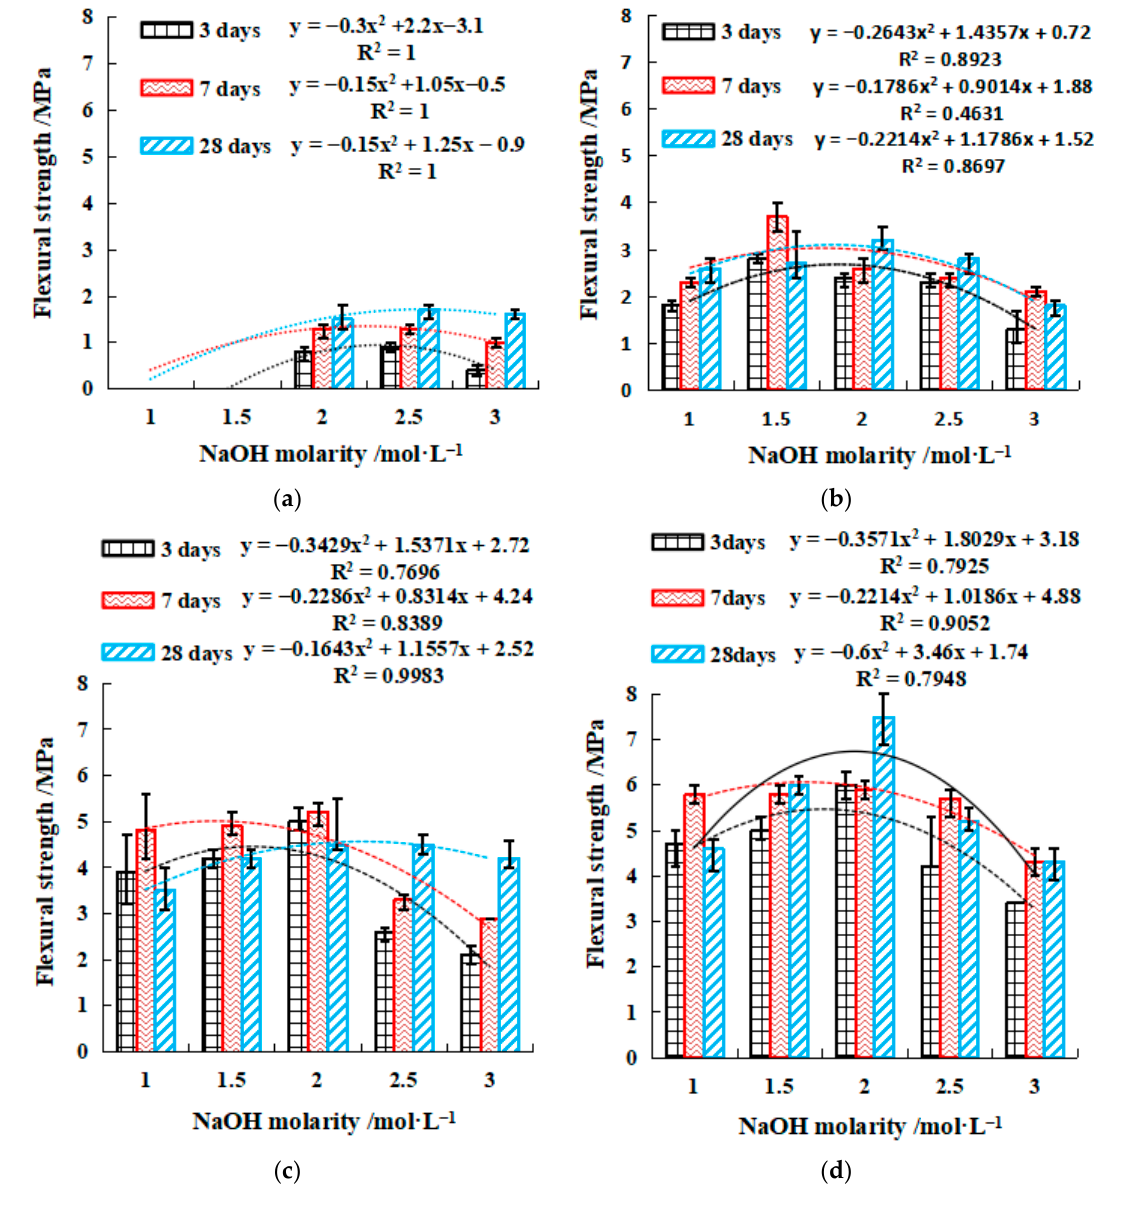
Figure 5. Flexural strength of single activator. ( a ) 10% GGBFS, ( b ) 20% GGBFS, ( c ) 30% GGBFS, ( d ) 40% GGBFS. y = ax 2 + bx + c, where y is the compressive or flexural strength, MPa. x is the NaOH molarity,1 ≤ x ≤ 3, mol·L − 1 . a, b, and c are coefficients.